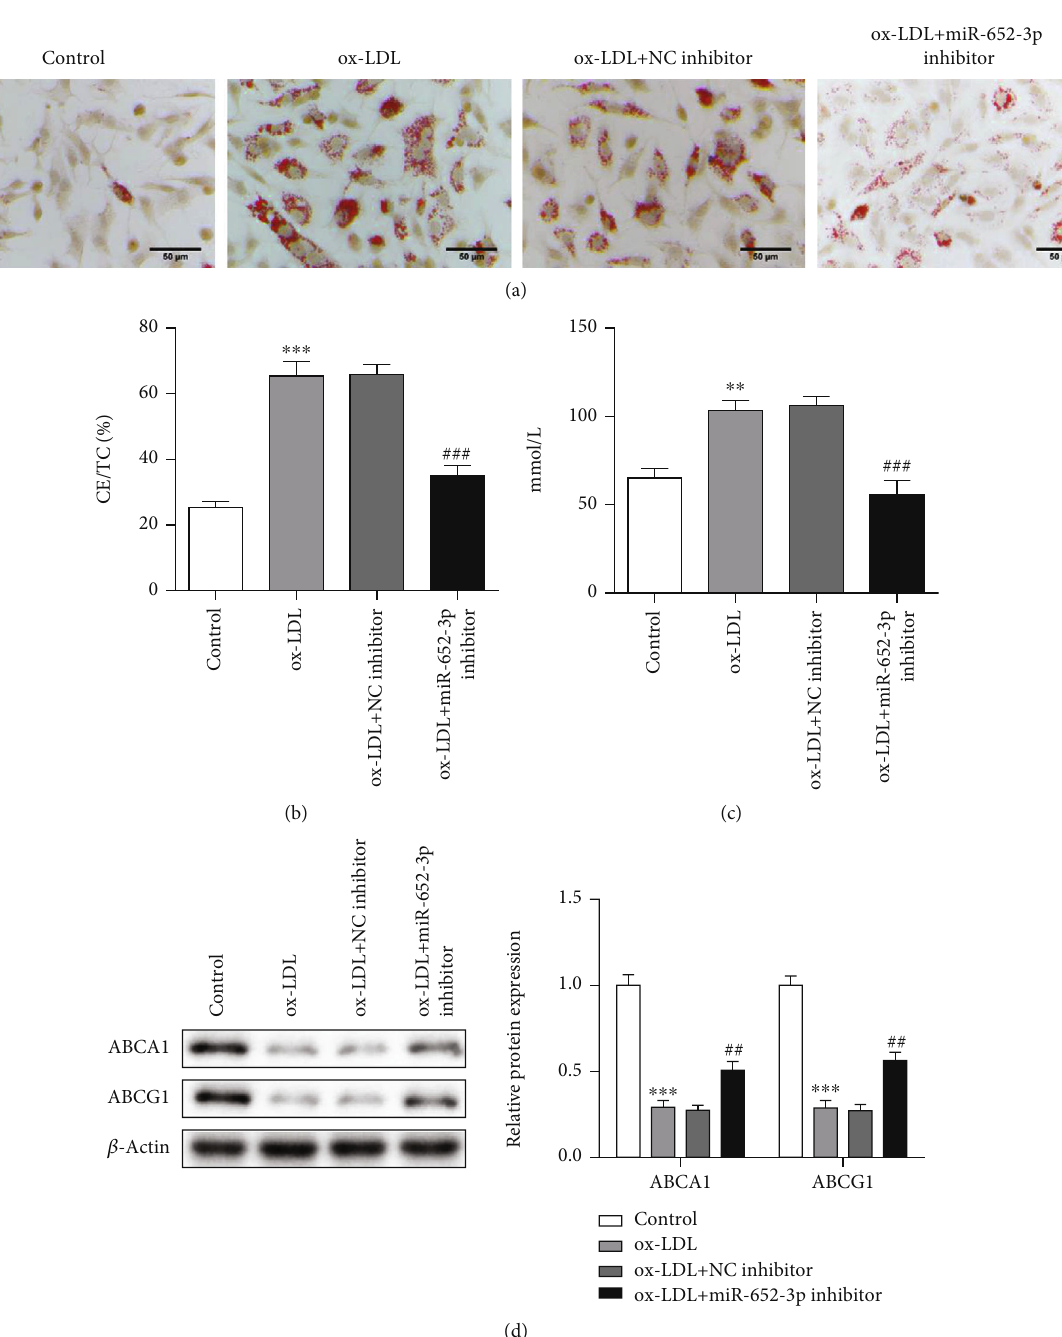
Figure 3: Knockdown of miR-652-3p reduces foam cell formation in ox-LDL-treated macrophages. (a) Oil red O staining. (b) The intracellular CE/TC ratio. (c) The cholesterol level of ox-LDL. (d) Western blot was processed to show ABCA1 and ABCG1 levels vs. control group, ∗∗∗ P < 0 : 001 vs. ox-LDL +NC inhibitor group, ### P < 0 : 001